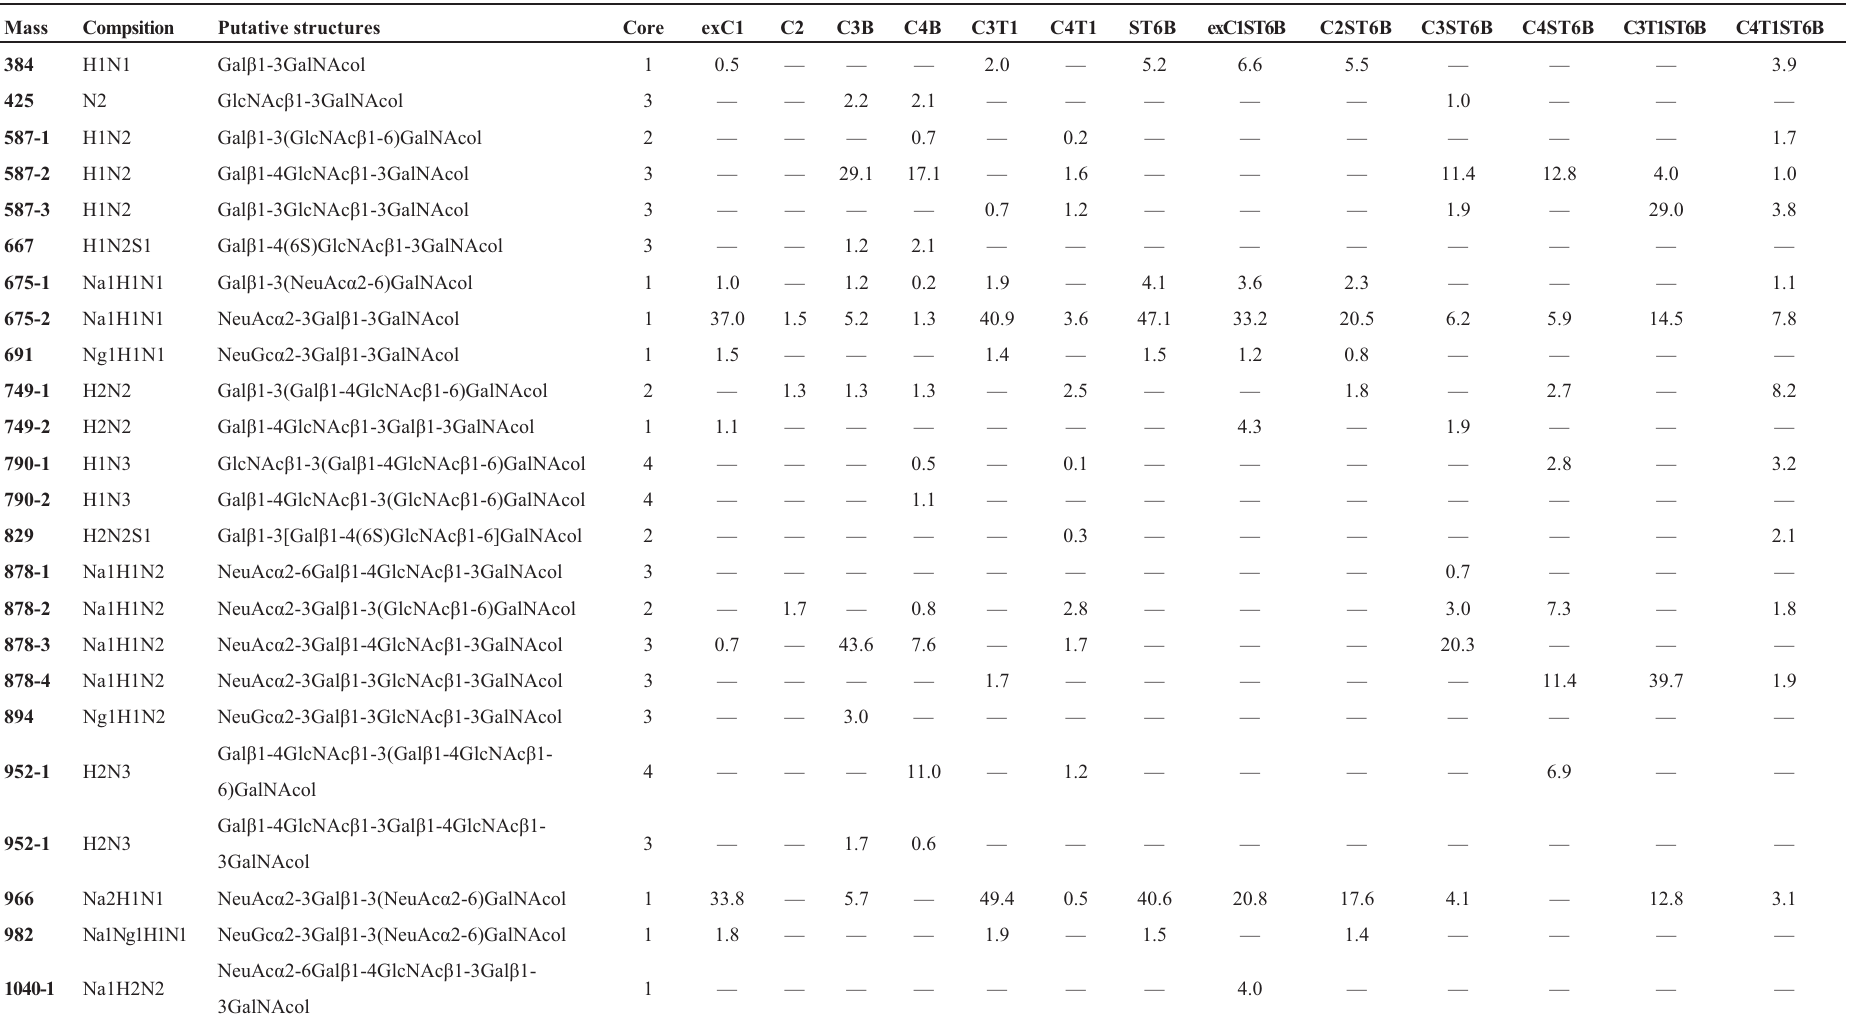
Table 1. Putative O -glycan repertoires on PSGL-1/mIgG2b produced in O -glycan core chain-engineered CHO cells and identified by LC-MS/MS. The relative amounts of the different O -glycans are given in percentage (%) of the total sum of integrated peak areas in the LC-MS chromatograms. H, hexose; N, N -acetylhexosamine; S, sulphate; Na/Ng, NeuAc/NeuGc; B, bulk-selected cell